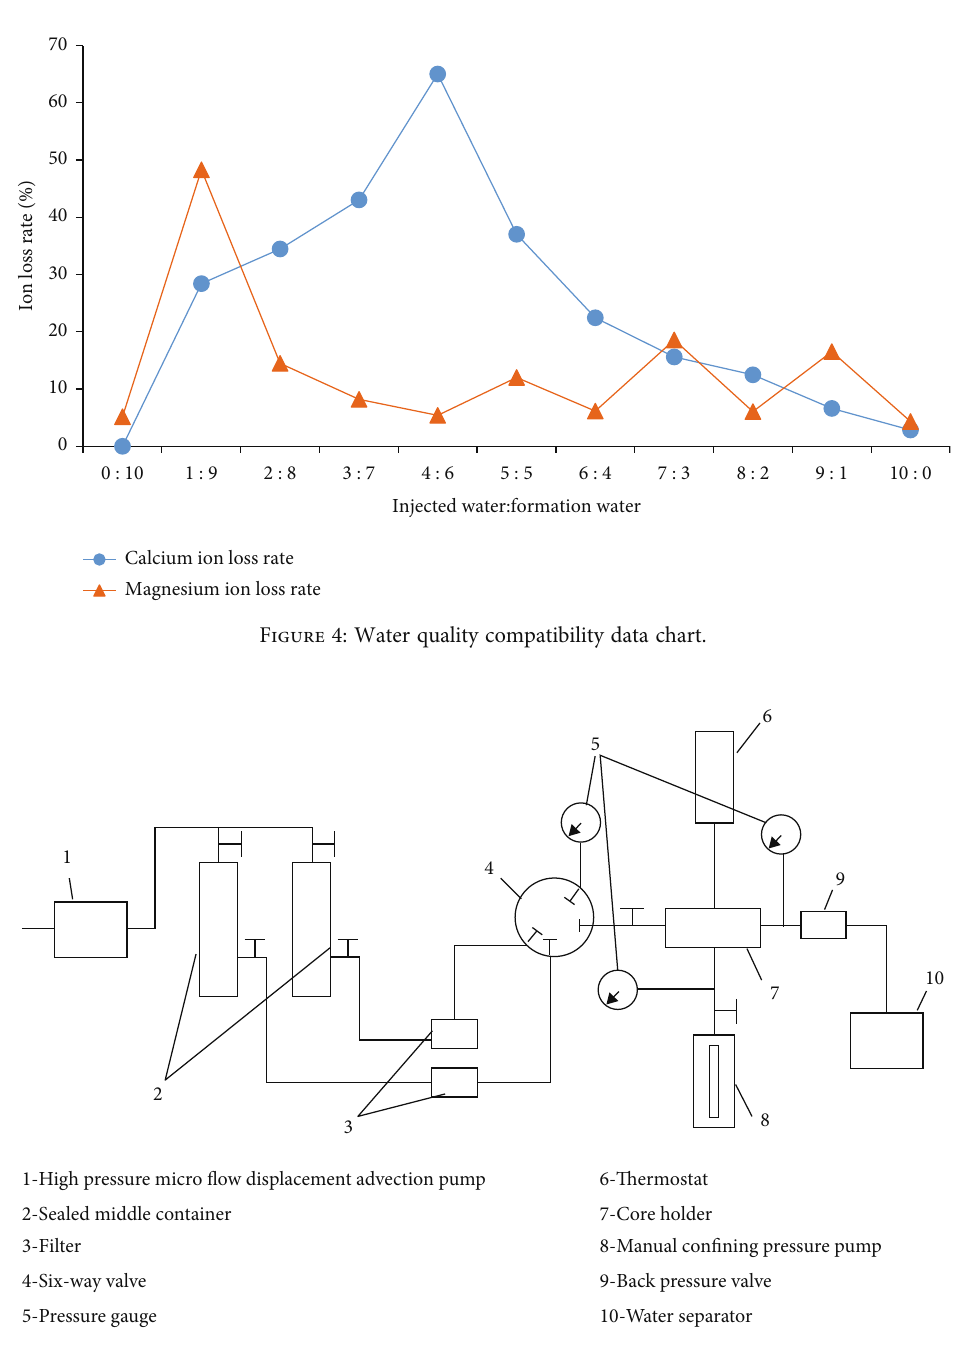
Figure 5: Flow chart of sensitivity experiment. 1: high pressure micro fl ow displacement advection pump; 2: sealed middle container; 3: fi lter; 4: six-way valve; 5: pressure gauge; 6: thermostat; 7: core holder; 8: manual con fi ning pressure pump; 9: back pressure valve; 10: water